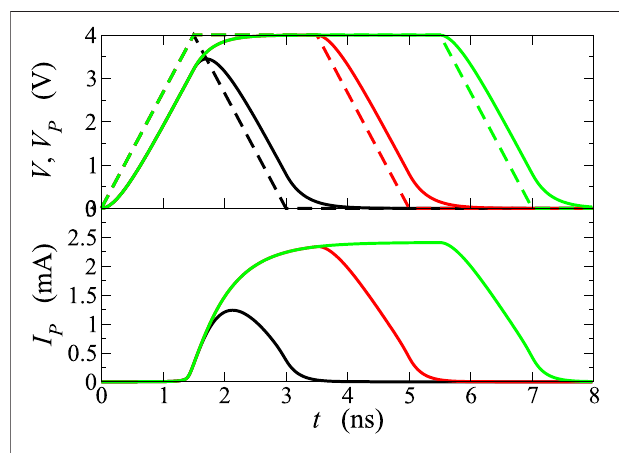
FIGURE 11 | Same as in Figure 10 , with different durations of the plateau of V ; here the latter is set at 4 V, and capacitance C is kept 300 pF.